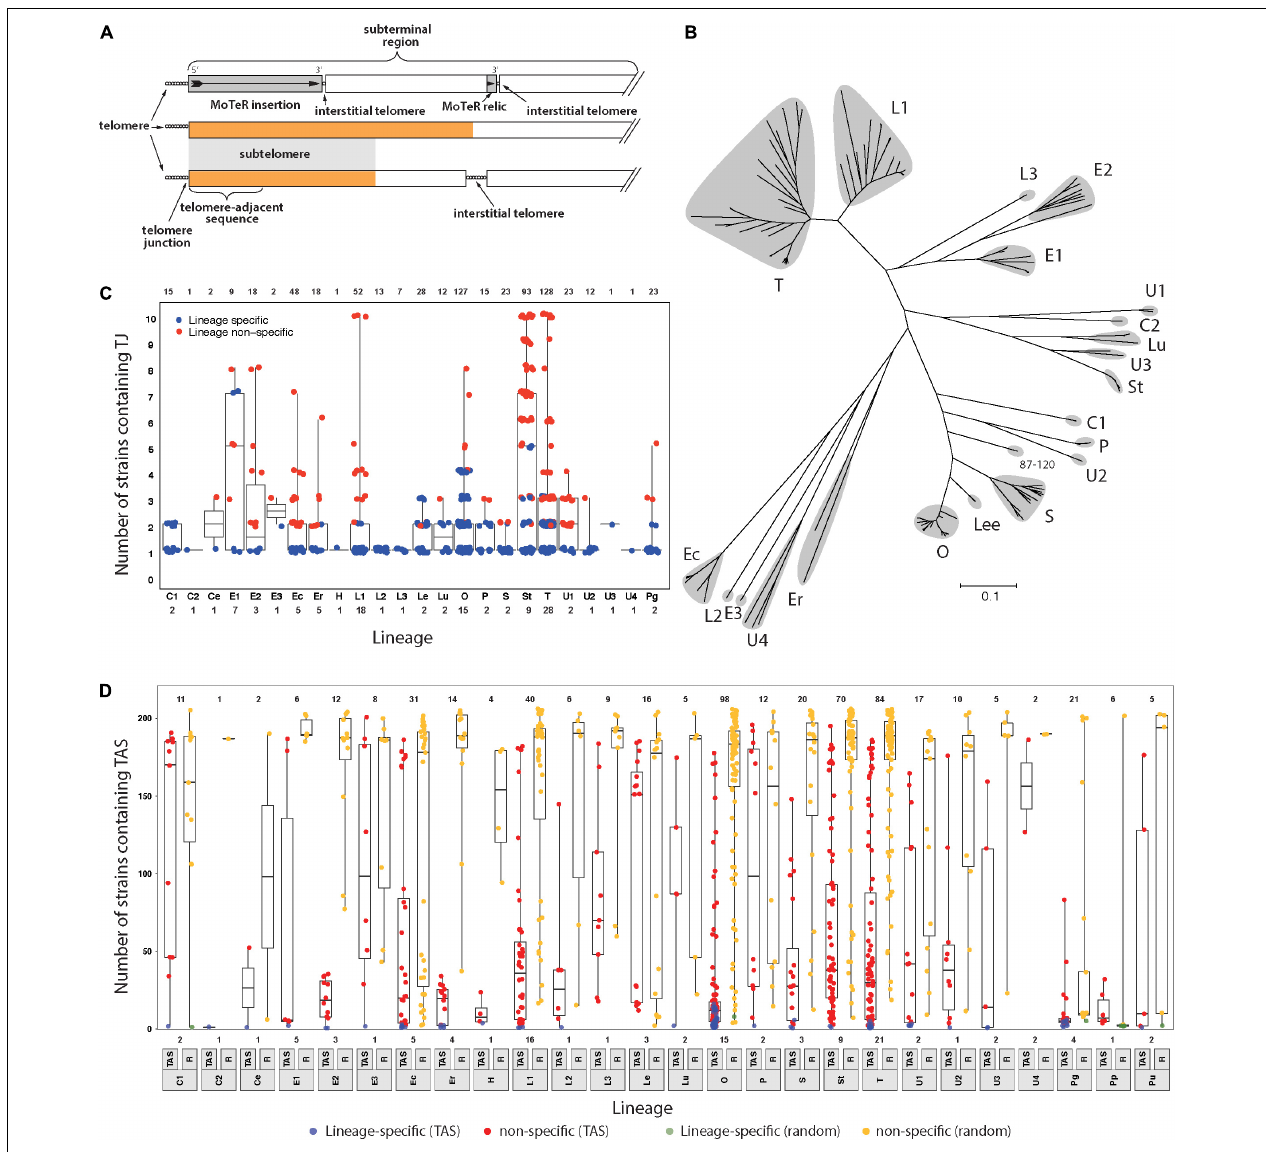
FIGURE 1 | Members of the Pyricularia species exhibit poor conservation of telomere junctions and adjacent sequences. (A) Schematic explaining telomere-related terminology. Telomeres = sequences at the chromosome ends; telomere-adjacent sequences (TAS) = immediately adjacent, and attached, to telomeres; telomere junctions (TJs) = boundaries between the telomeres and TAS; subterminal regions = portions of chromosomes near to the ends. These can be arbitrary lengths; subtelomeres = sequences present in the subterminal regions and duplicated at multiple chromosome ends; interstitial telomeres = telomeric sequence motifs at internal chromosome positions that can be generated by MoTeR insertion, MoTeR relic formation, telomere internalization, or possibly through random sequence matches. The orange color is used to represent a specific sequence motif, to illustrate how the “subtelomere” designation strictly only extends to subterminal sequences shared with at least one other chromosome end. (B) Neighbor joining tree showing genetic relationships between different P. oryzae lineages based on whole genome SNP analysis. Branch lengths correspond to pairwise distances between isolates (% nucleotide divergence). Gray “clouds” highlight the major host-specialized lineages and are labeled according to most common host (C = Cynodon ; E = Eleusine ; Ec = Echinochloa ; Er = Eragrostis ; L = Lolium ; Lee = Leersia ; Lu = Luziola ; O = Oryza ; P = Panicum ; S = Setaria ; St = Stenotaphrum ; T = Triticum and U = Urochloa ). Distinct lineages that came from the same host are given different numerical suffixes. See Supplementary Figure 1 for the expanded Pyricularia tree. (C) Boxplots showing the distribution of specific TJs among isolates. Each datapoint represents a single TJ identified in a given isolate. Plots are organized according to phylogenetic lineages/species (see labels below x -axis). Blue color indicates that the telomere junction was lineage-specific. Box boundaries show the 25th and 75th percentiles and the horizontal line the median value. Note that TJs linked to MoTeR sequences were excluded from this analysis. (D) Boxplots showing the distribution of telomere adjacent sequences (TAS) and random sequences among isolates. TAS were filtered to remove repeated sequences and then used to search masked genome sequences. An equivalent number of random sequences (RS) were sampled for comparison. Each datapoint shows the numbers of blast matches found for each TAS/RS identified in a given isolate. Plot organization and percentiles are as in panel (B) . Blue and green colors respectively indicate that the TAS or RS were lineage-specific. Values at the top indicate numbers of TAS analyzed. Values at the bottom show numbers of strains analyzed from each lineage/species (lineage labels are shown below the x -axis).